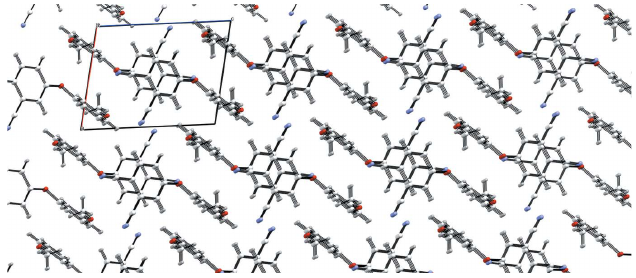
Figure 6 A view along the b axis of the crystal packing of o -4-(3-methoxyphen- oxy)phthalonitrile. Intermolecular hydrogen bonds have been removed for